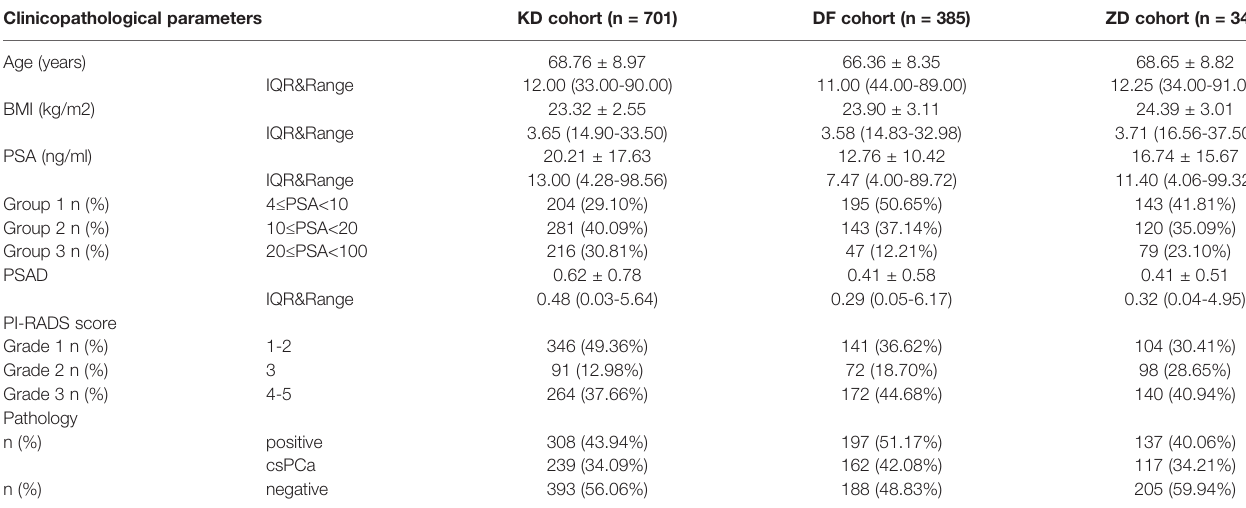
TABLE 1 | Demographic characteristics of the patients in development cohort and validation cohorts. Clinicopathological